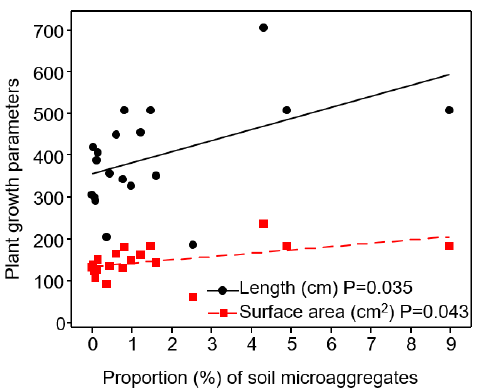
Figure 2. The relationship between the abundance (proportion of total) of soil microaggregates and root length (cm) and area (cm 2 ), as determined by the linear regression. Since both root length and area had different units, and are also plotted together, we named the y -axis “plant growth parameters to represent root traits simultaneously”.